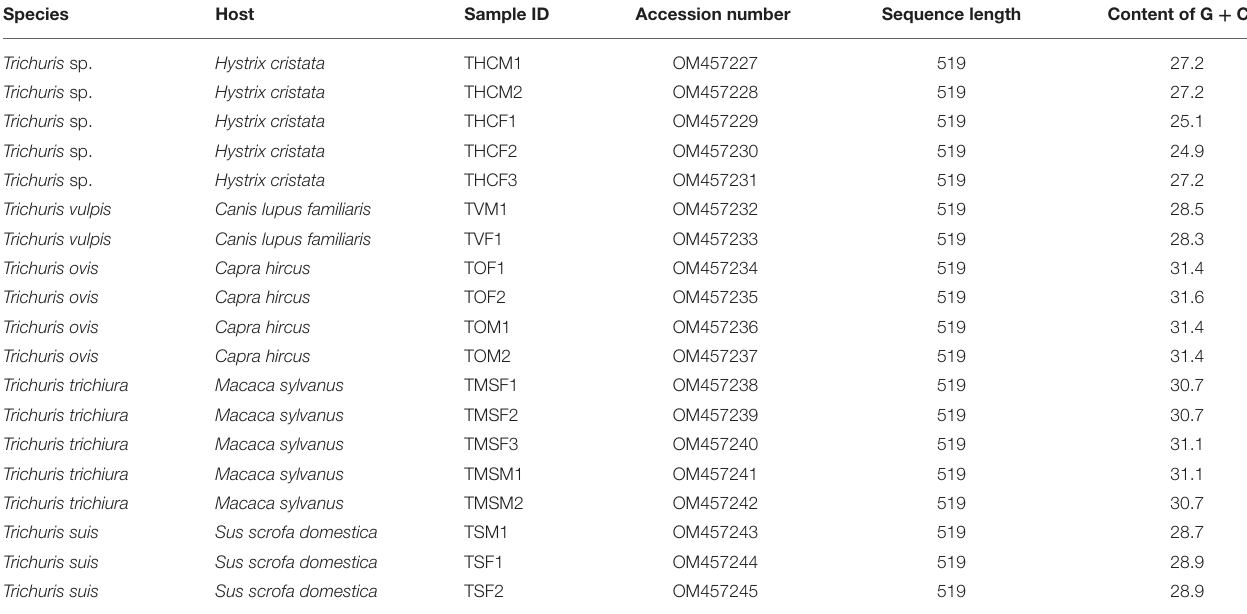
TABLE 3 | Summary of the Trichuris sequences obtained in this work and available in GenBank database. Species Host Sample ID Accession number Sequence length Content of G + C% Trichuris sp.